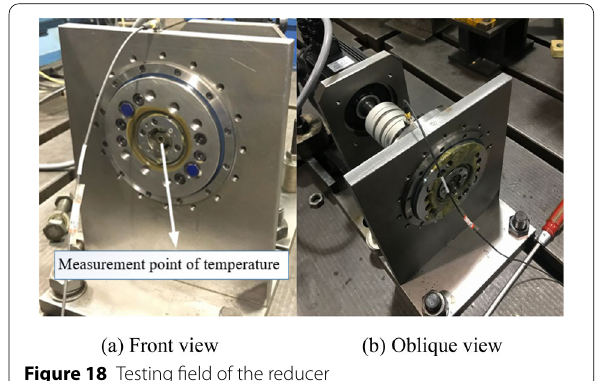
Figure 18 Testing field of the reducer